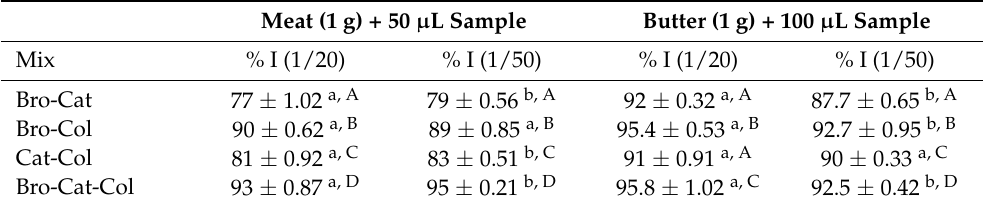
Figure 9. Percentage of inhibition of TBArs in butter at ambient temperature by the peptides-minerals complexes, for the < 3000 fraction, E:C ratio 1/20 and 1/50, peptide-mineral complex volume 100 µ L (Col = collagenase B, Bro = bromelain, Cat = cathepsine B). Columns label interpretation: (i) different lowercase letters indicate differences among enzymes for the 1/20 ratio; (ii) different uppercase letters indicate differences among enzymes for the 1/50 ratio; (iii) for each enzyme, different symbols indicate differences among ratios. Table 5. Percentage of TBArs inhibition (% I) for peptides-minerals mixing, <3000 Da fractions, 1/20 and 1/50 E:C ratios, at ambient Temperature .